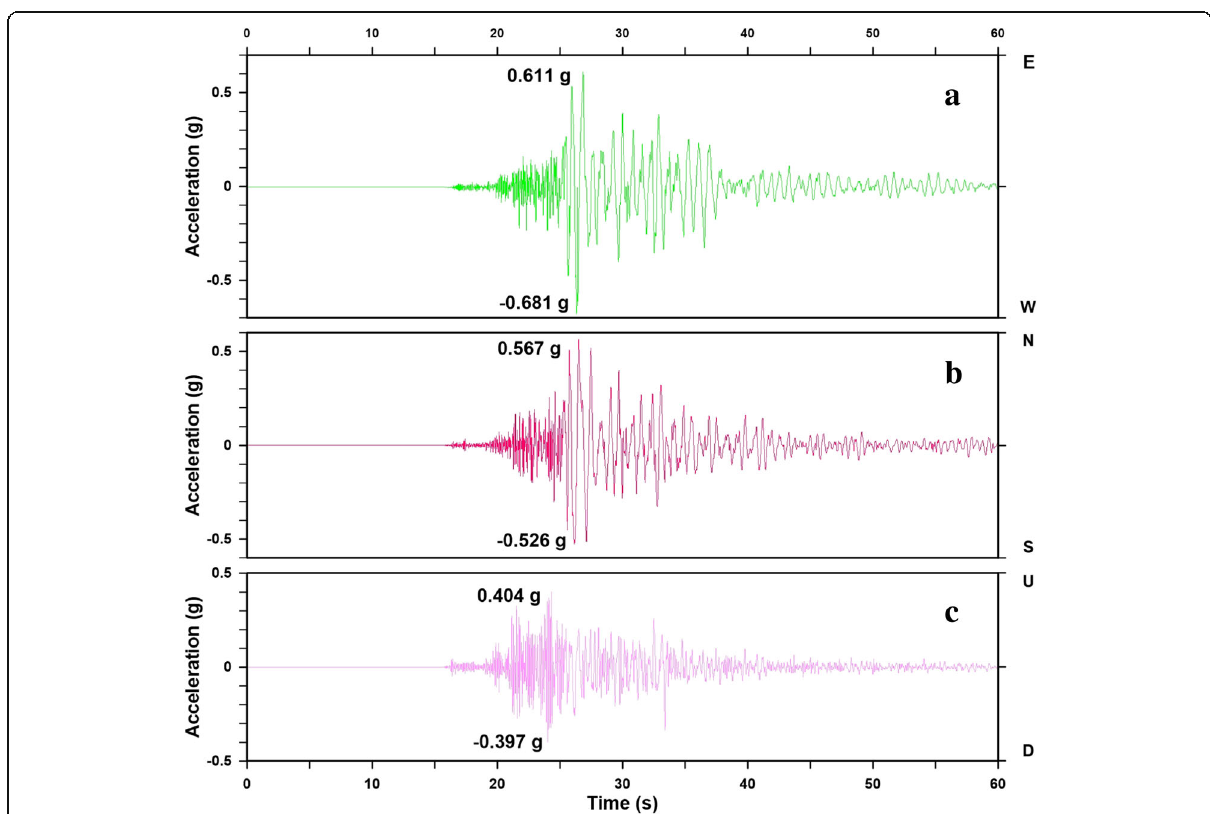
Fig. 7 Ground accelerations of three orthogonal directions (EW, NS and UD) observed by a K-NET station (HKD128) during the Iburi earthquake. a Ground acceleration in EW direction. b Ground acceleration in NS direction. c Ground acceleration in UD (up and down) direction. The ground acceleration data are derived from the National Research Institute for Earth Science and Disaster Prevention